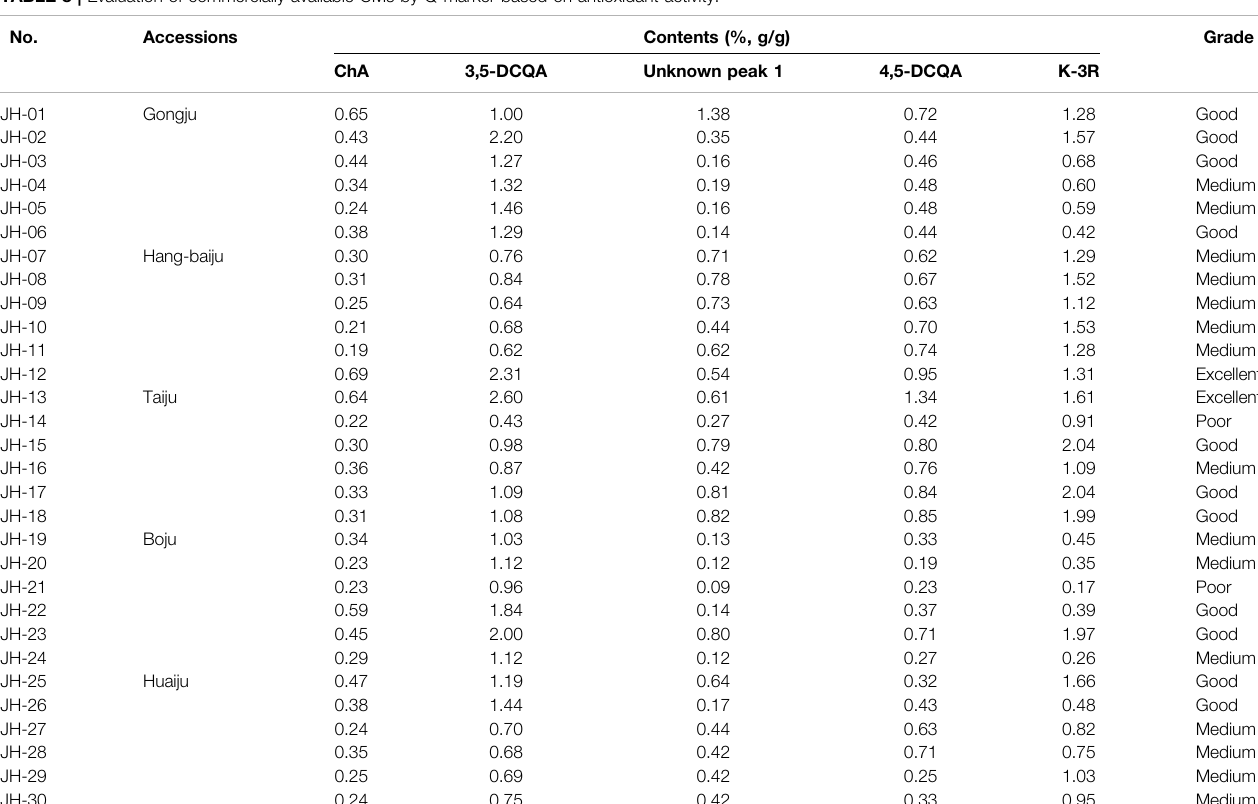
TABLE 8 | Evaluation of commercially available CMs by Q-marker based on antioxidant activity.